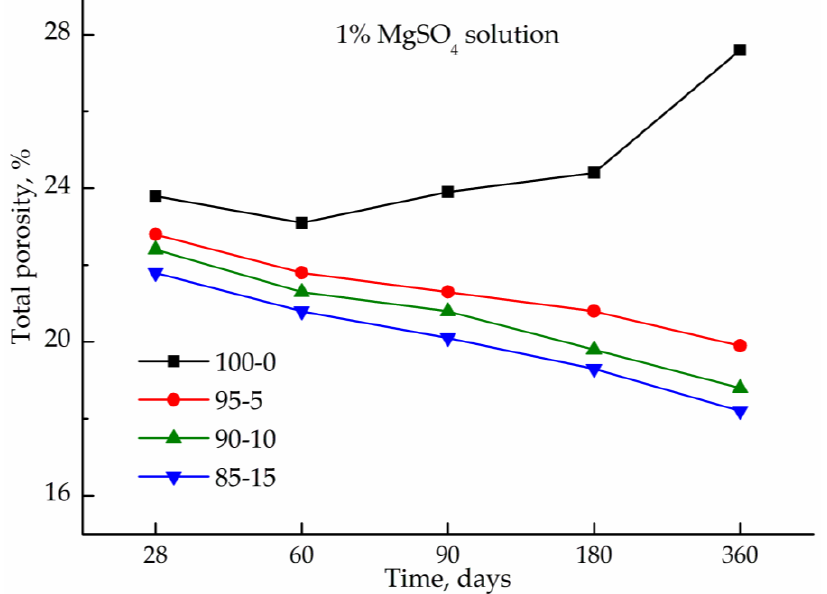
Figure 7. Total porosity of the mixed cement specimens hardened in 1% MgSO 4 solution.